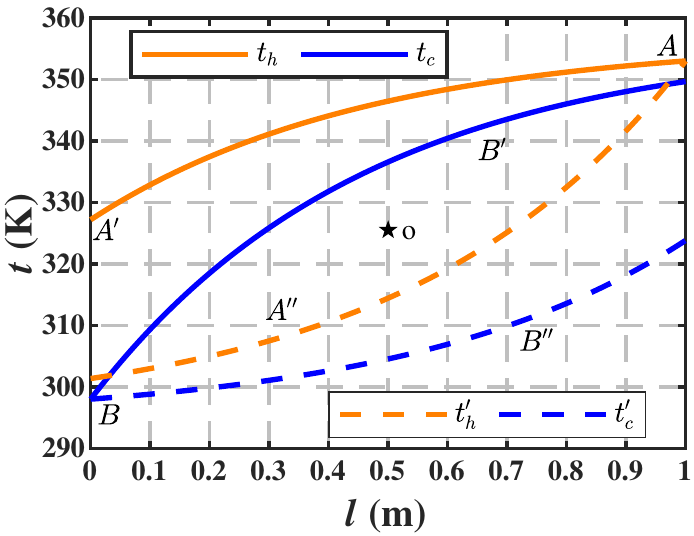
Figure 5. Temperature profiles of the demonstrated